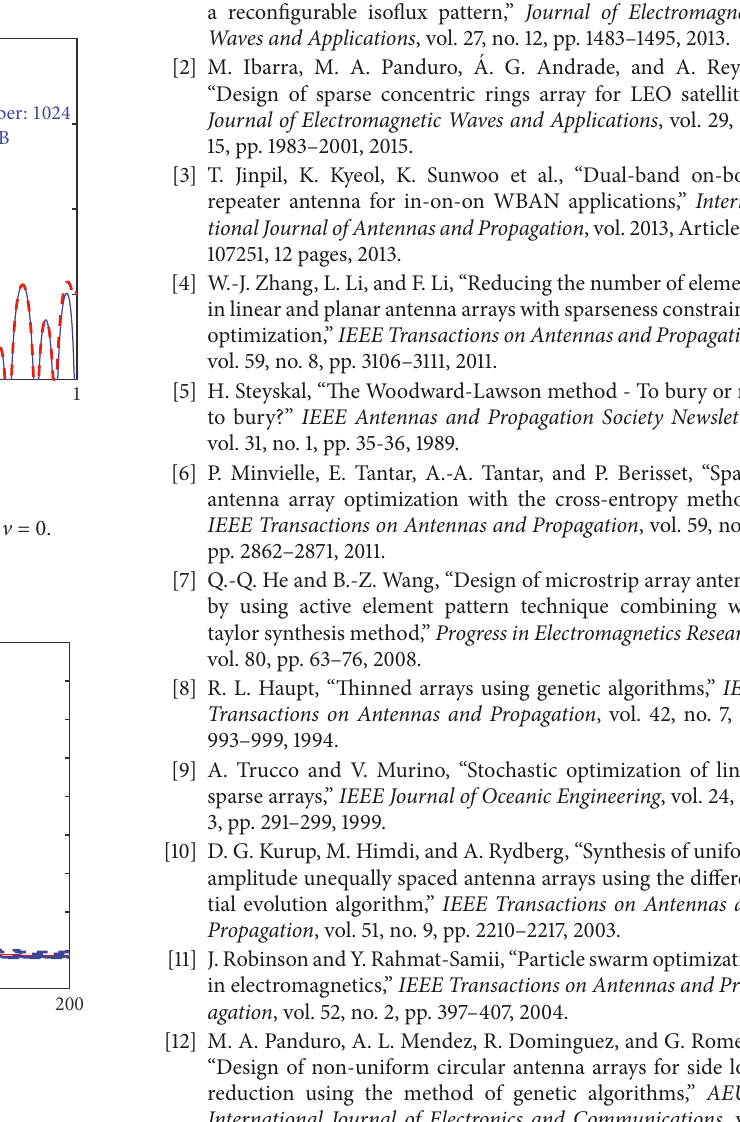
Figure 9: Radiation pattern of the optimal result.